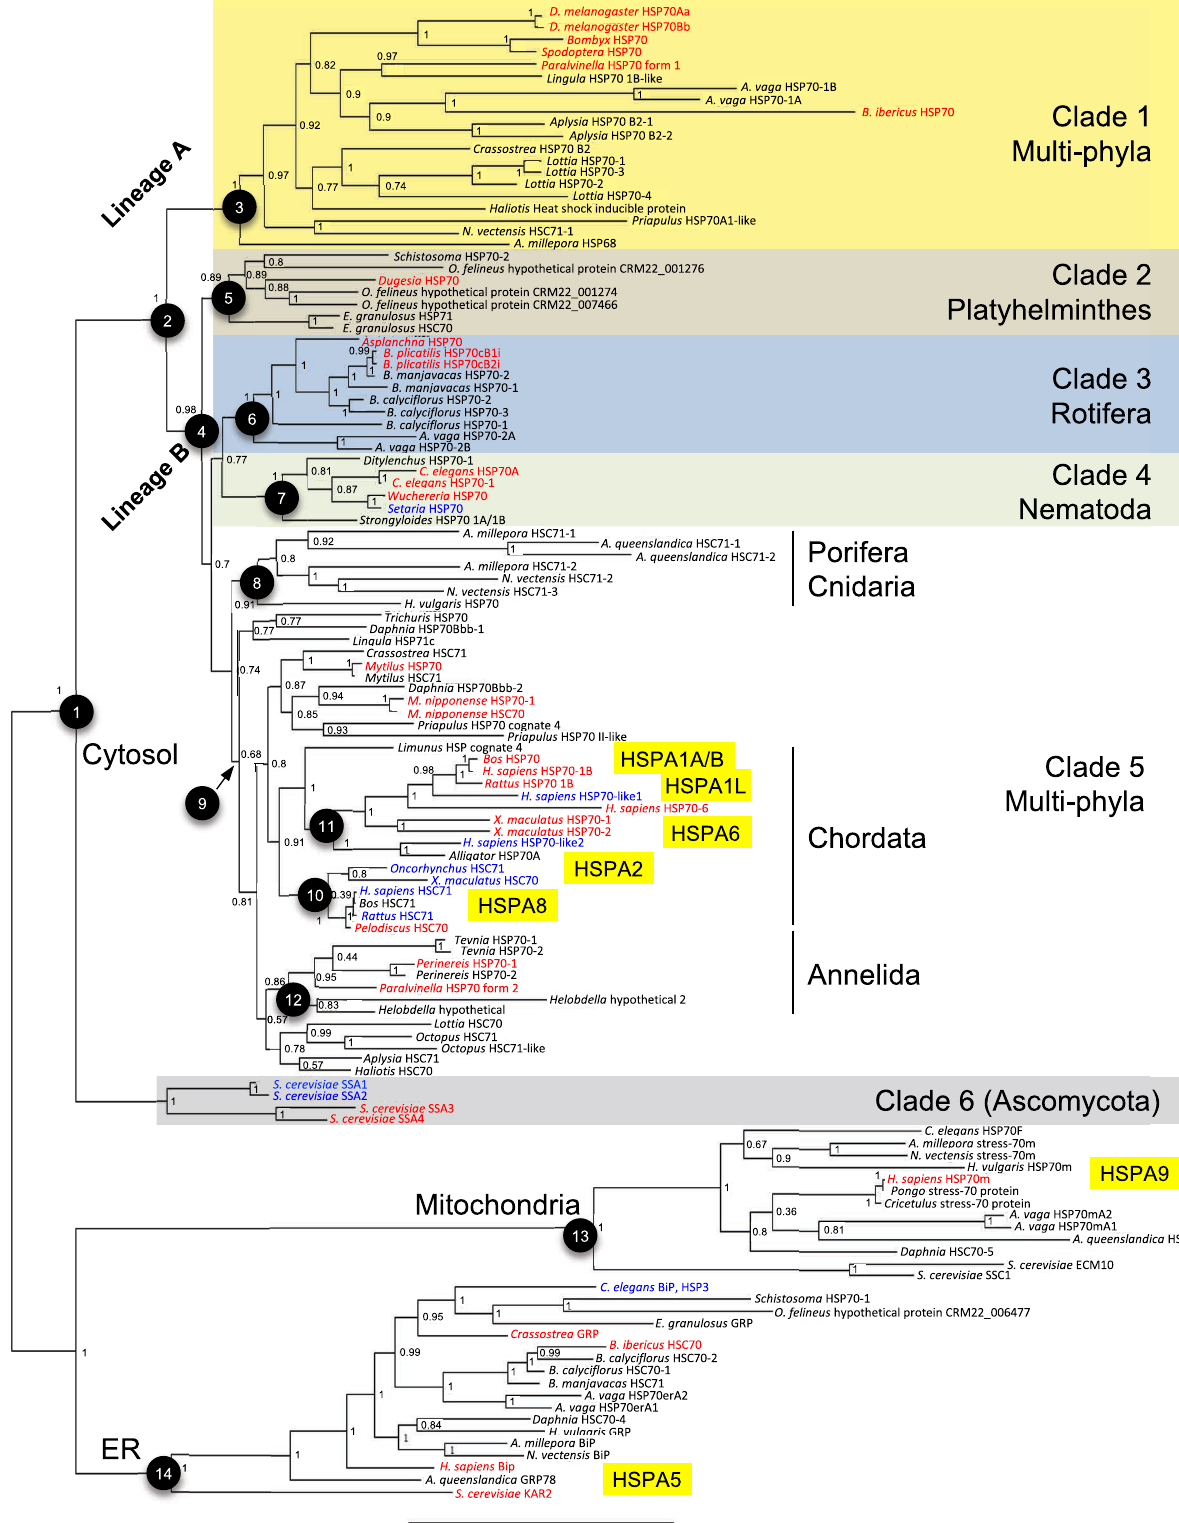
Figure 1. Bayesian consensus tree of HSP70 family members. Nodes discussed in the text are indicated. Numbers on the branches indicate the posterior probability support for each node. Stress-inducible and constitutive genes are shown in red and blue, respectively. No data on the stress inducibility is available for genes shown in black. Approved HGNC names of human HSP70 family members are shown in yellow boxes for reference. The DDBJ/EMBL/GenBank accession numbers and other information are summarized in Supplementary Table S1. Clades 1 to 6 include only cytosolic members of the HSP70 family. Human HSPA1A and HSPA1B have identical sequences at the amino acid level and are shown